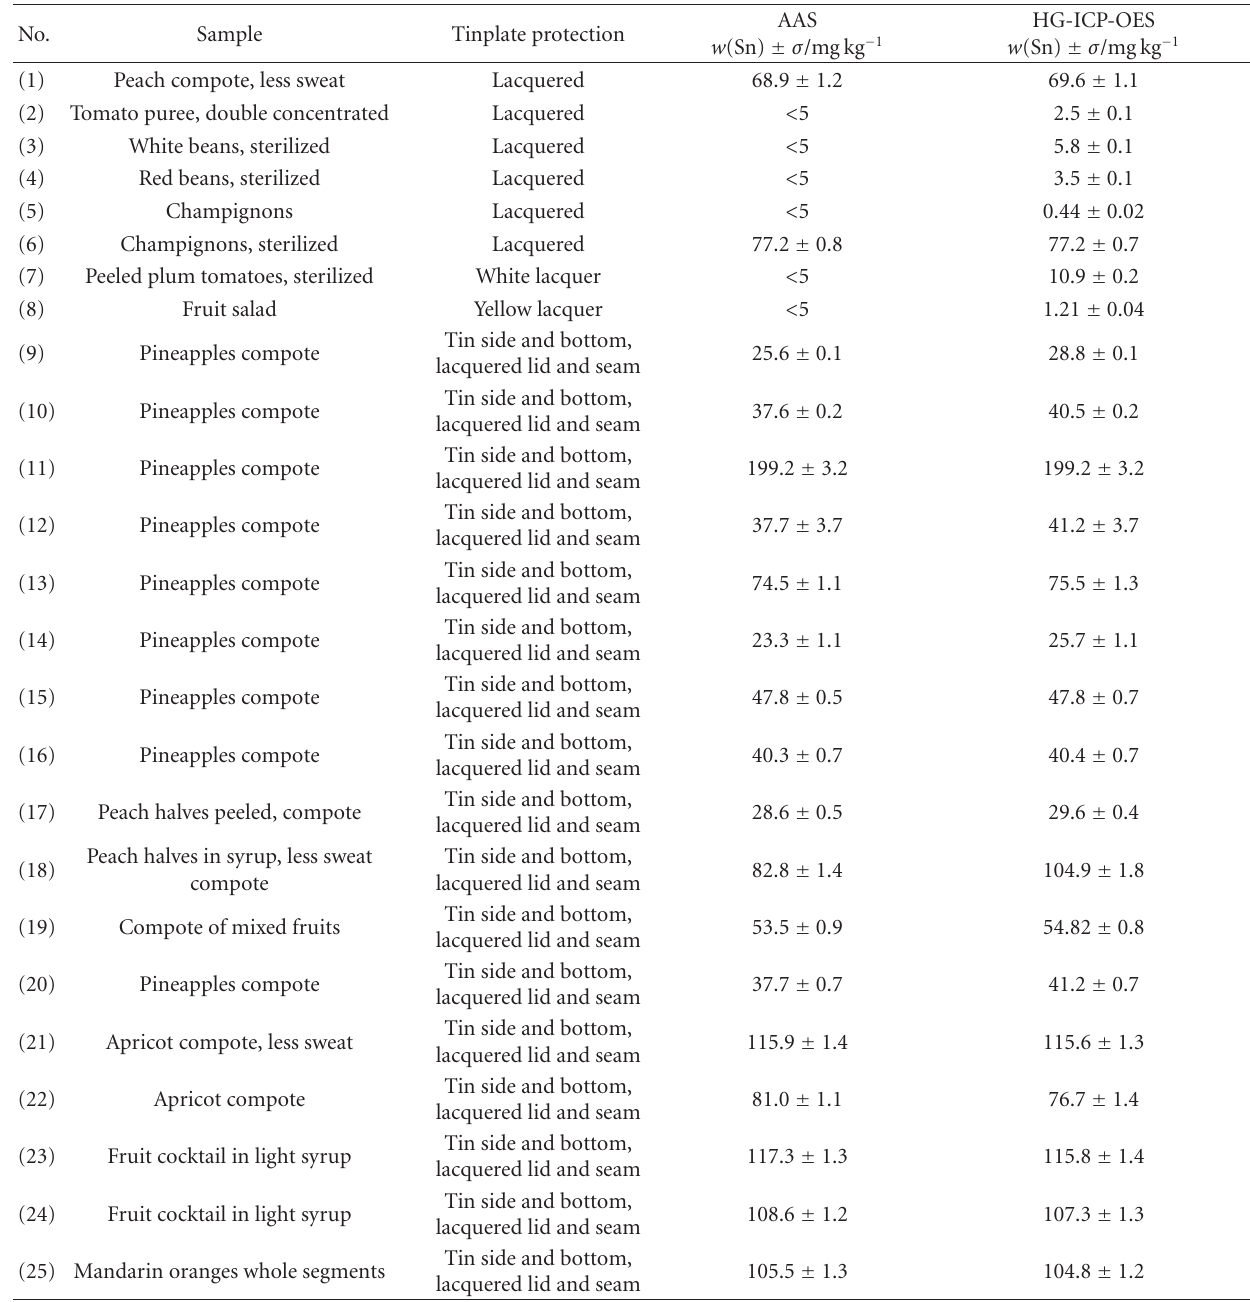
Table 3: Tin content in canned fruit determined by AAS and HG-ICP-OES (mean of two replicate samples, n = 3).